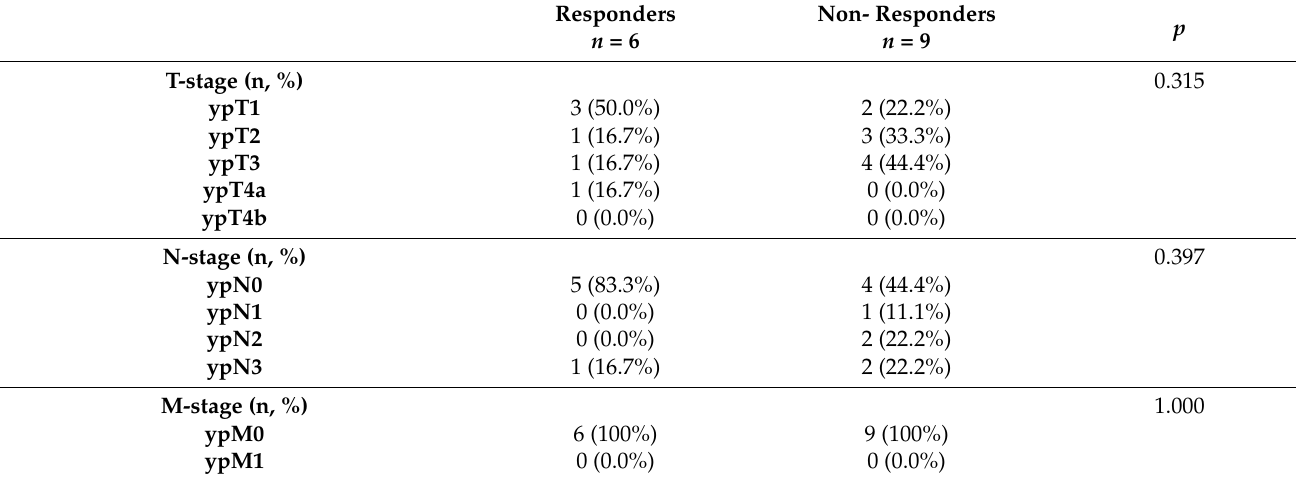
Table 2. Oncological outcomes including ypTNM stage, resection margin, node details, and lymphovascular/perineural invasion in responder vs. non-responder